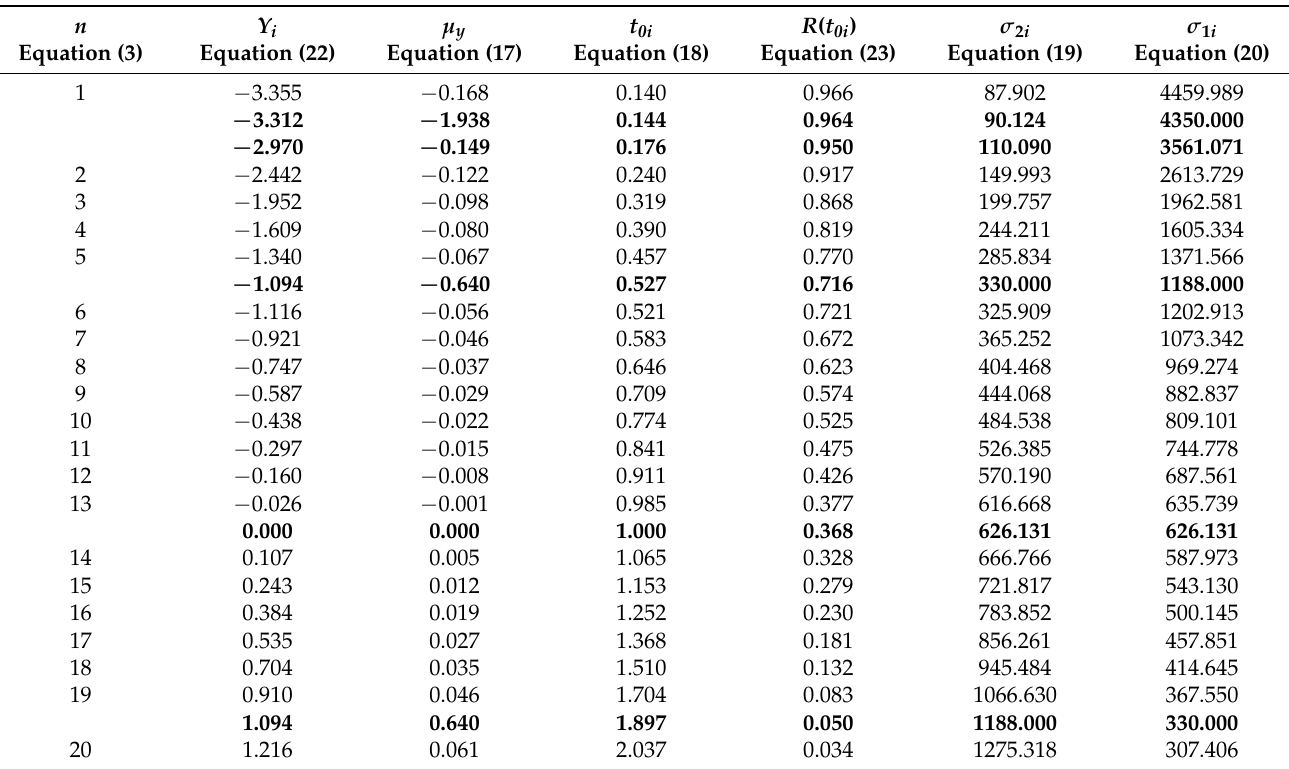
Table 4. Weibull statistics for vibration